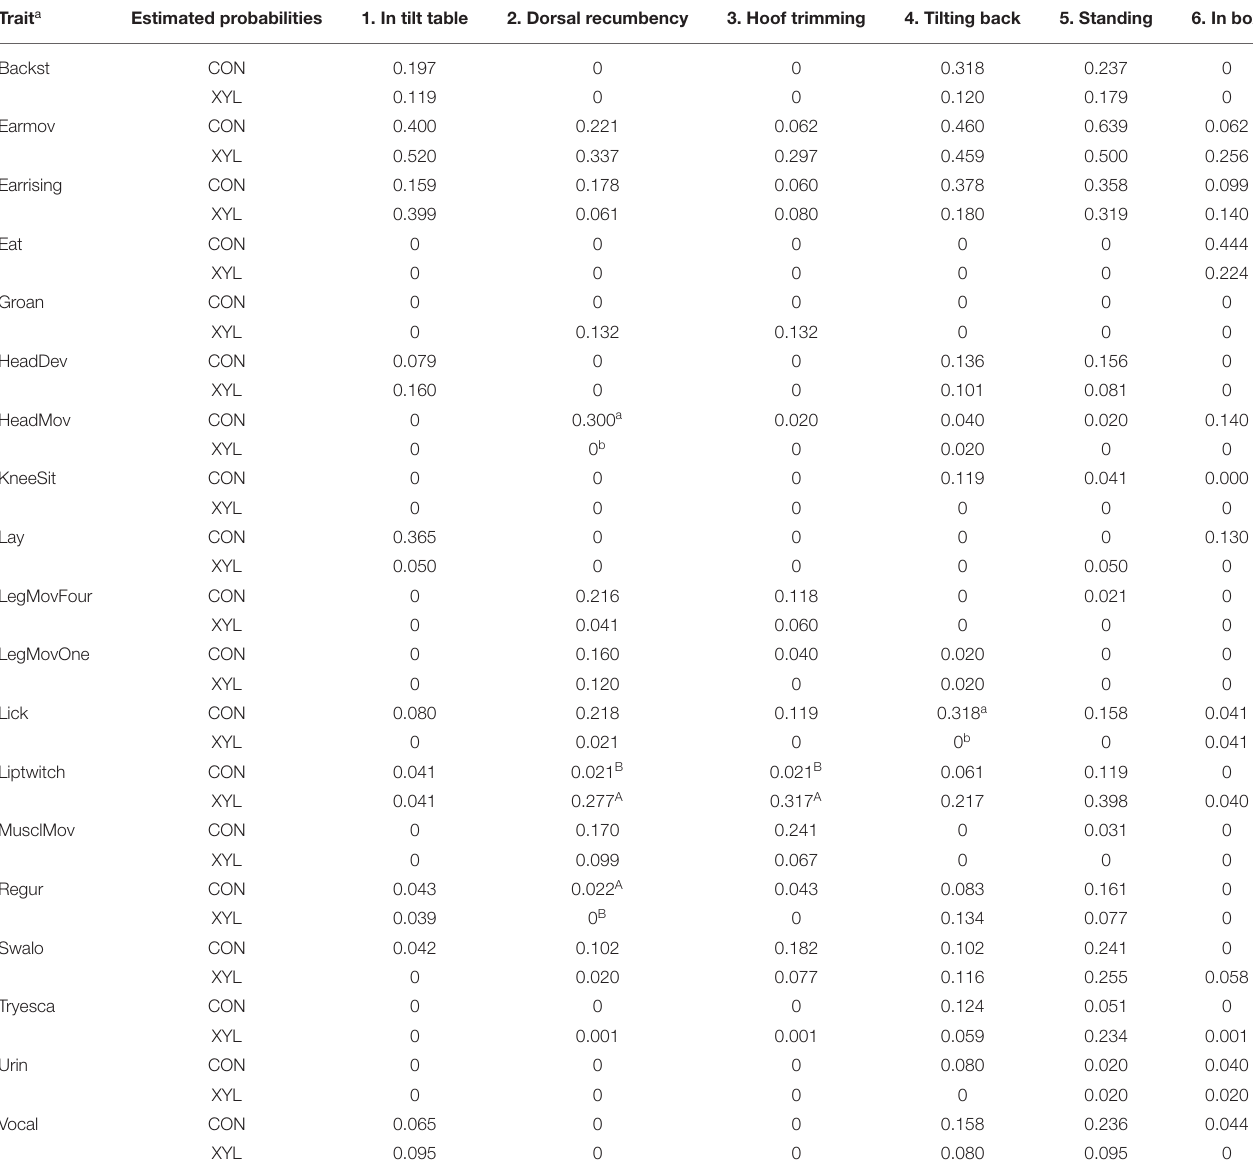
p ij of occurrence of behavioral traits for the treatments (CON, XYL) within the j-th position (j TABLE 7 | Estimated probabilities ˆ between treatments within positions (Tukey-test; for reasons of clarity, the CI of the estimates are not given here). Trait